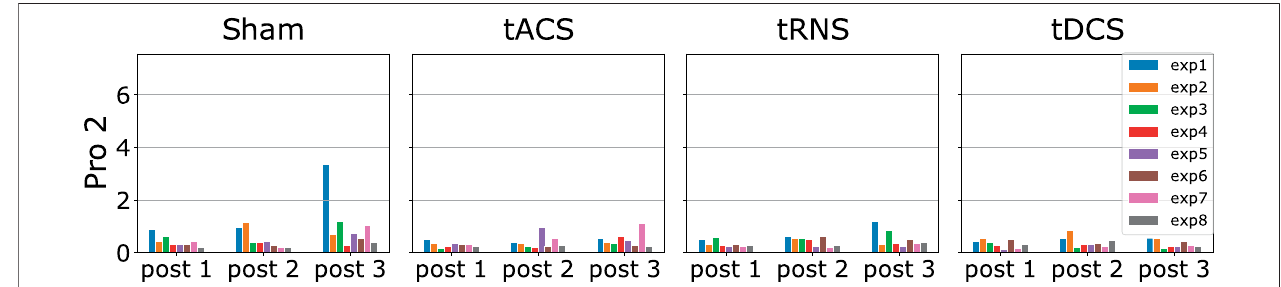
FIGURE 13 | We provide a set of post-processed trajectories with fi ltering (A) and without fi ltering (B) . Frequencies higher than 20 Hz are fi ltered out. A high similarity between fi tted results using ProMPs can be observed, especially the automatic fi ltering effect can be seen from the green curve at its peak value, marked in